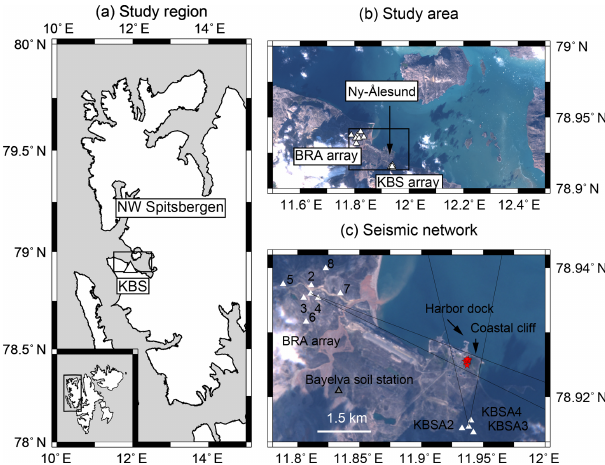
Figure 1. Study area, location of instrumentation, and seismic tremor source. (a) Map of northwest Spitsbergen, part of the Arctic archipelago of Svalbard (lower left corner), and location of perma- nent seismic station KBS. (b) Study area around Ny-Ålesund and location of temporary BRA and KBSA arrays. The black rectangle shows map section in panel (c) . (c) More detailed location of seis- mic stations and a coastal cliff with shallow cave shown in Fig. 5d being the source of a repeating seismic tremor (see Sect. 5). Red stars are tremor locations between April and August 2016. Black lines indicate azimuthal measurement uncertainty when using FK analysis independently on both arrays. Center station of BRA array is BRA1. Numbers indicate the other instrument locations. Back- ground images: Copernicus Sentinel data